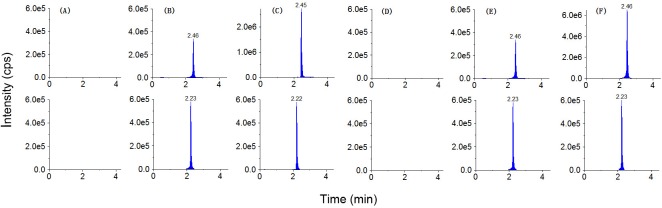
LC–MS/MS chromatograms of gemifloxacin (upper row) and ciprofloxacin (bottom row). (A) Blank dialysate of skeletal muscle; (B) blank skeletal muscle dialysate spiked with gemifloxacin (40 ng/mL); (C) dialysate of skeletal muscle collected 4 h after the administration of gemifloxacin, i.v. (18 mg/kg); (D) blank dialysate of plasma; (E) blank plasma dialysate spiked with gemifloxacin (40 ng/mL); (F) dialysate of plasma collected 4 h postdose.